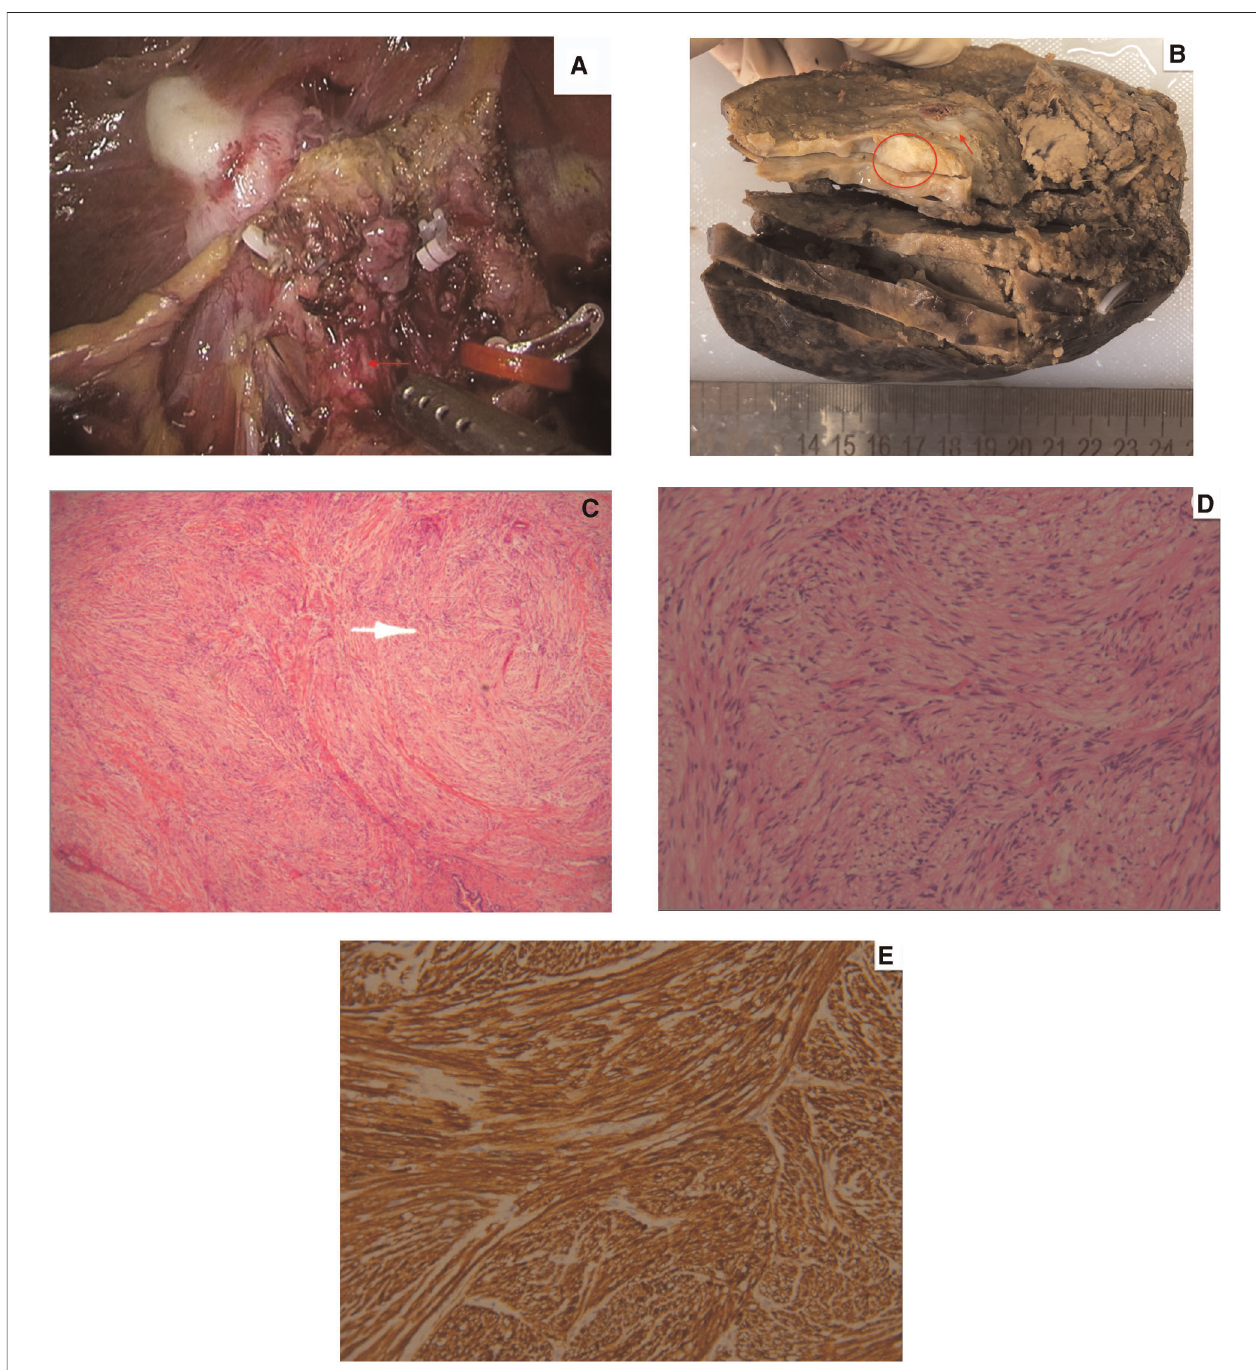
FIGURE 3 | ( A ) Intraoperative fi ndings revealing an atrophied gallbladder, with a hardened texture (the red arrow points out the tumor). ( B ) Grayish-white nodule (pointed by the red arrow) seen at the neck of the gallbladder (represented by the red circle). ( C ) Low-magni fi cation and ( D ) high-magni fi cation pathological analysis showing spindle cells. ( E ) Immunohistochemical positivity of